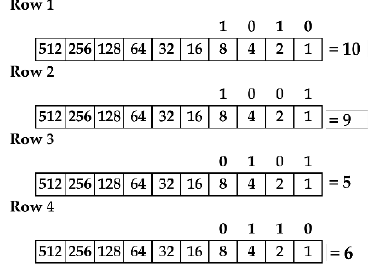
Figure 10. Translation of binary values to decimal values.